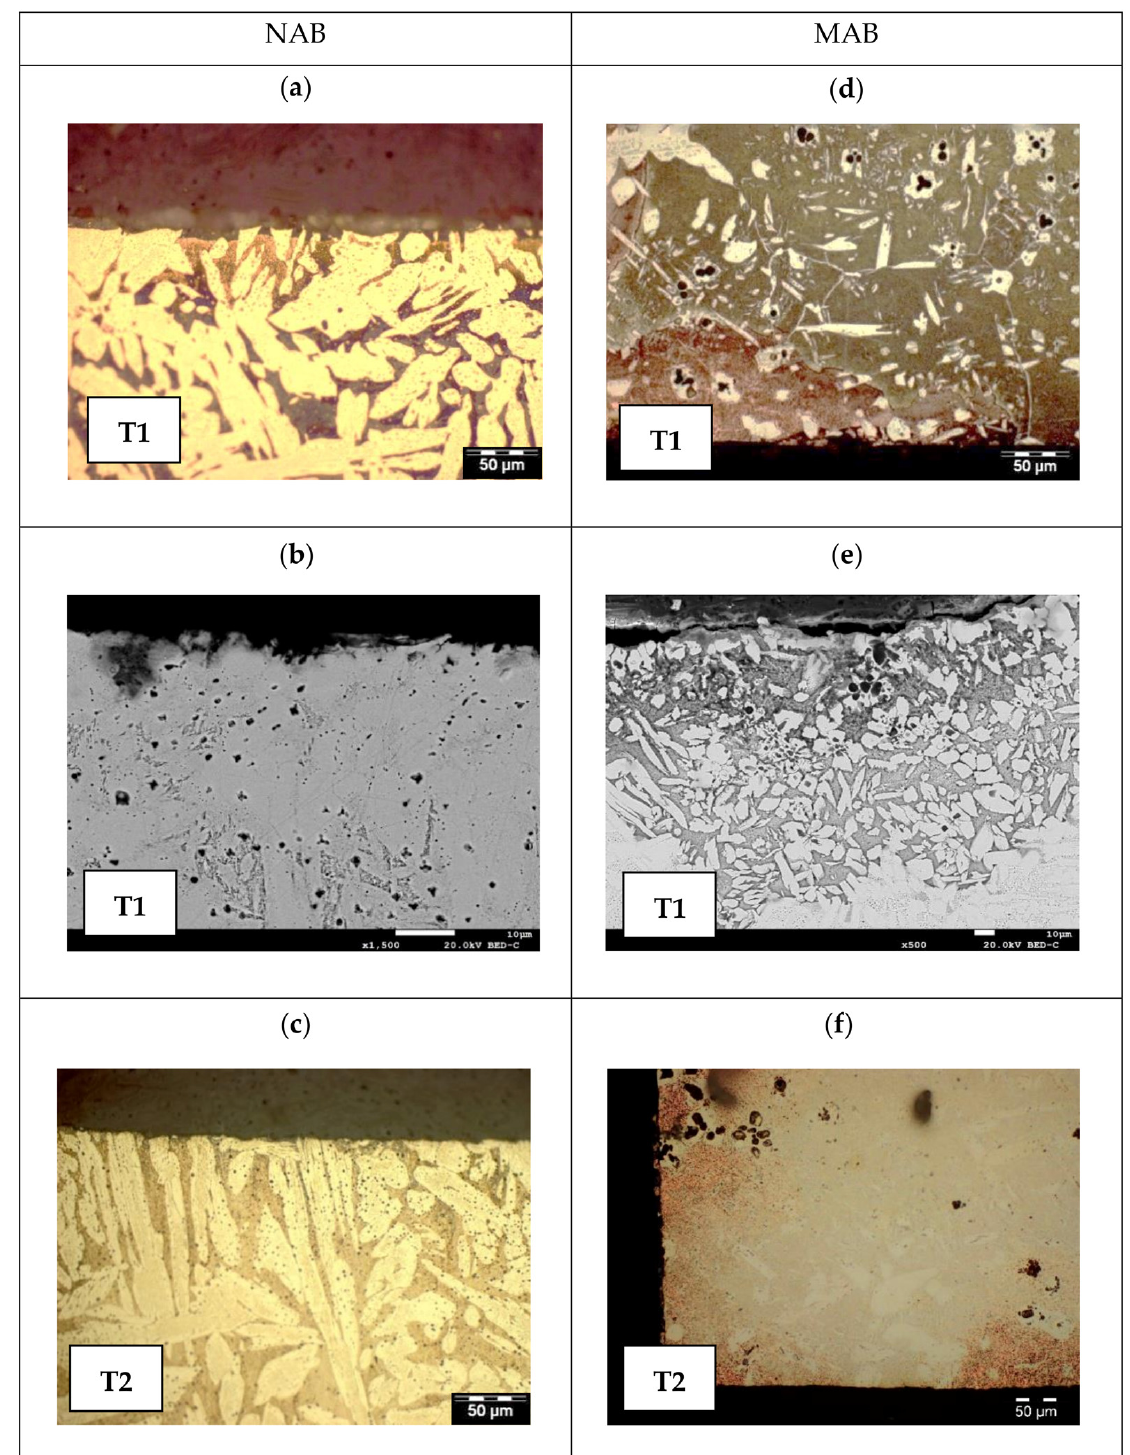
Figure 8. LOM pictures of T1 and T2 samples after potentiostatic corrosion testing in SFW at +350 mV SCE for NAB ( a , c ) and MAB ( d , f ), and SEM pictures of T1 samples ( b , e ).